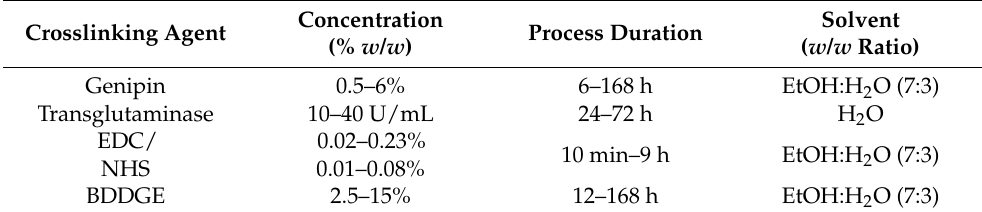
Table 1. Crosslinking